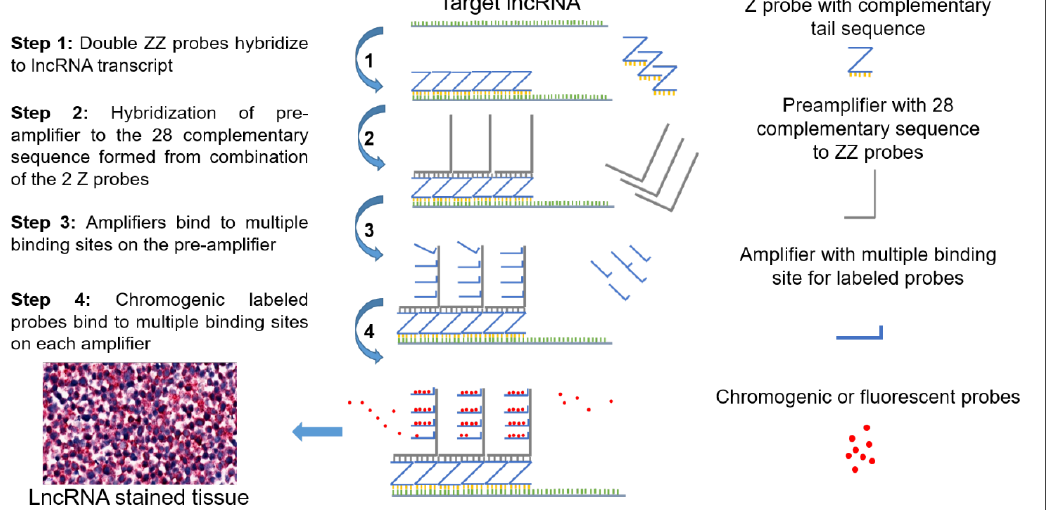
Figure 2. Validation and optimization of the Z-probe staining. Paraffin embedded, and sectioned, pancreatic cancer tissue, colorectal cancer tissue and HeLa cell pellet were stained with a negative